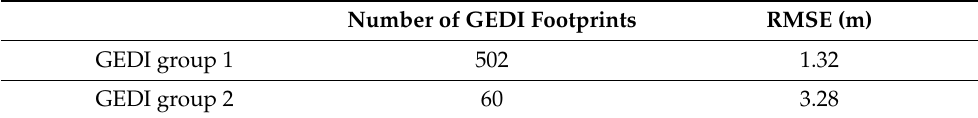
Figure 10. Boxplots showing the distribution of dh-DTM. Data selection with 0.9 sensitivity thresh- old ( a ). Useful data along all sensitivity ranges ( b ). Table 5. Statistics from GEDI footprint groups.